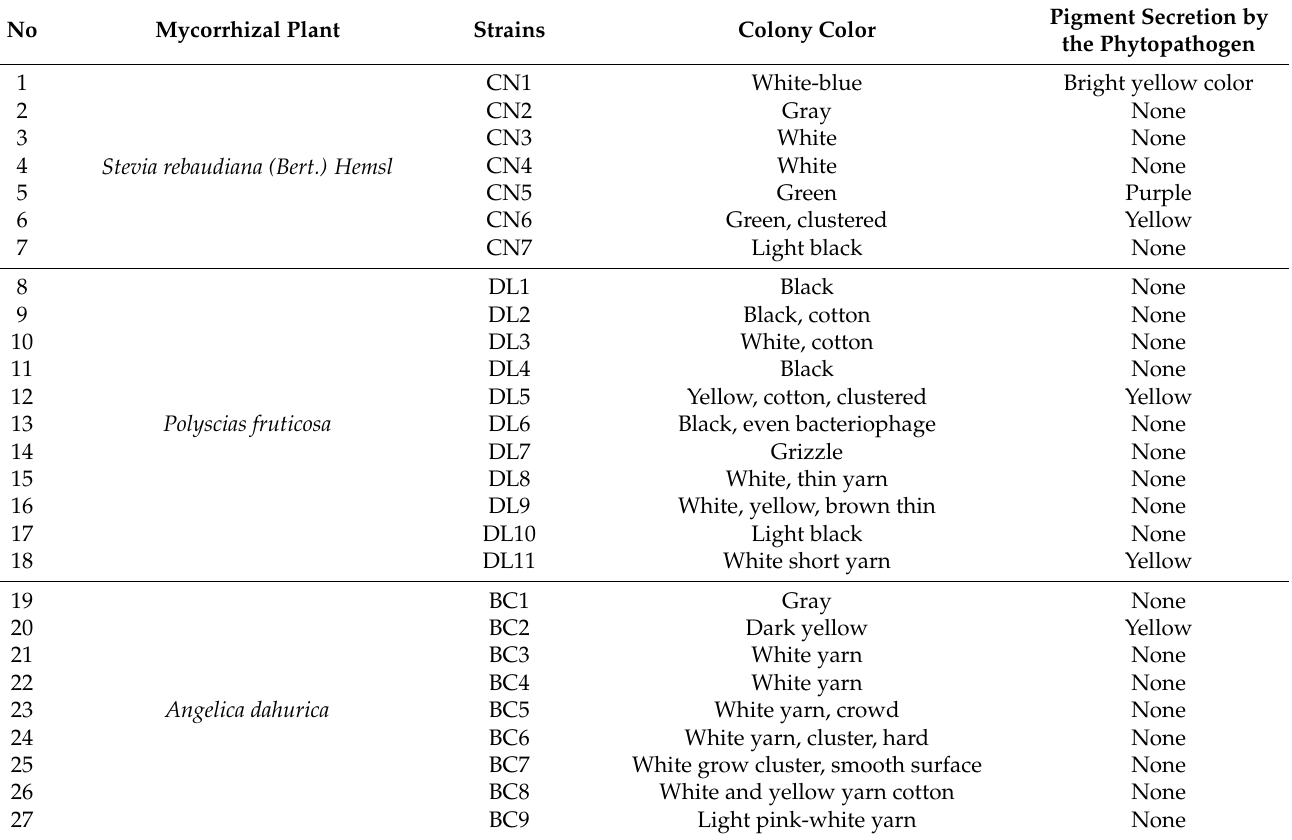
Table 1. Characterization of the isolated fungal strains.